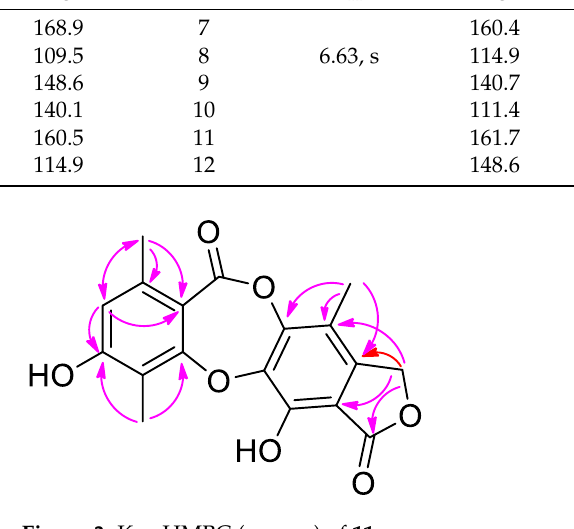
Figure 3. Key HMBC (arrows) of 11 .